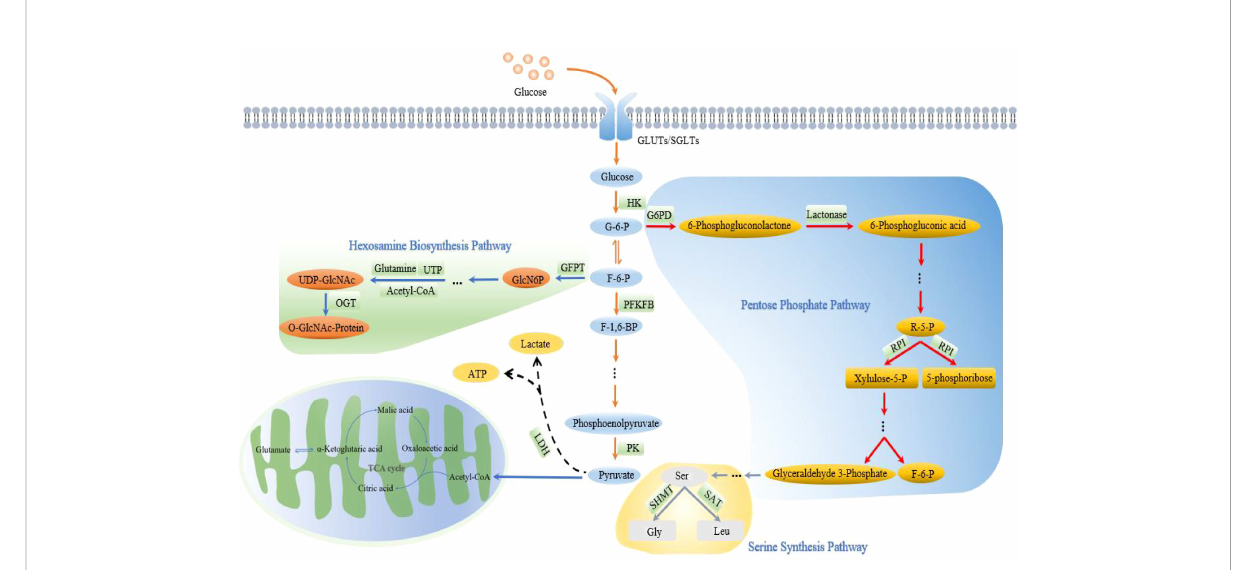
FIGURE 1 Aerobic glycolysis in PC. The entire process of glucose uptake and conversion and utilization through a series of pathways, including aerobic glycolysis pathway to generate lactate and ATP, PPP pathway to generate 5-phosphate ribose, serine pathway to generate Gly and Leu and hexosamine biosynthesis pathway to generate O-GlcNAc is